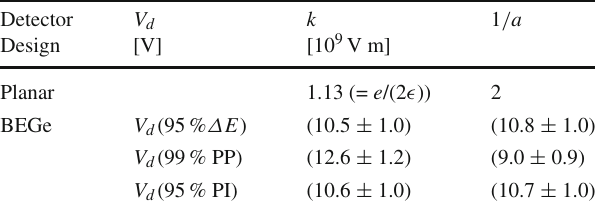
BEGe with 1 bubble BEGe with 2 bubbles GD91 BEGe series